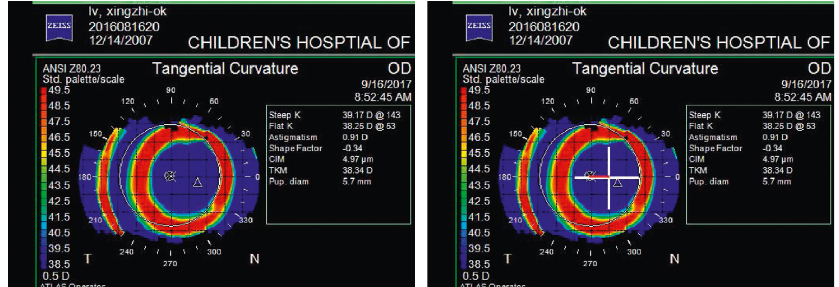
Figure 2: The measurement of treatment zone decentration. The length of the red line in the right part is the amount of